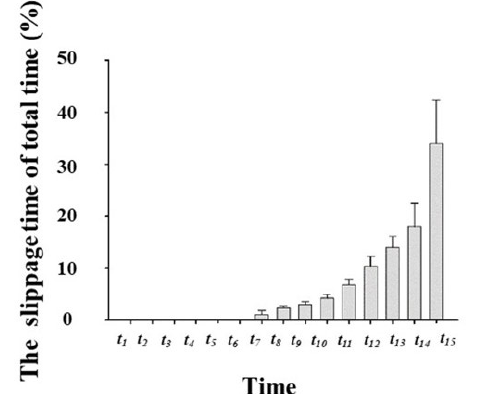
Figure 6 - Percentage of electrical stimulation time of total time by time period.